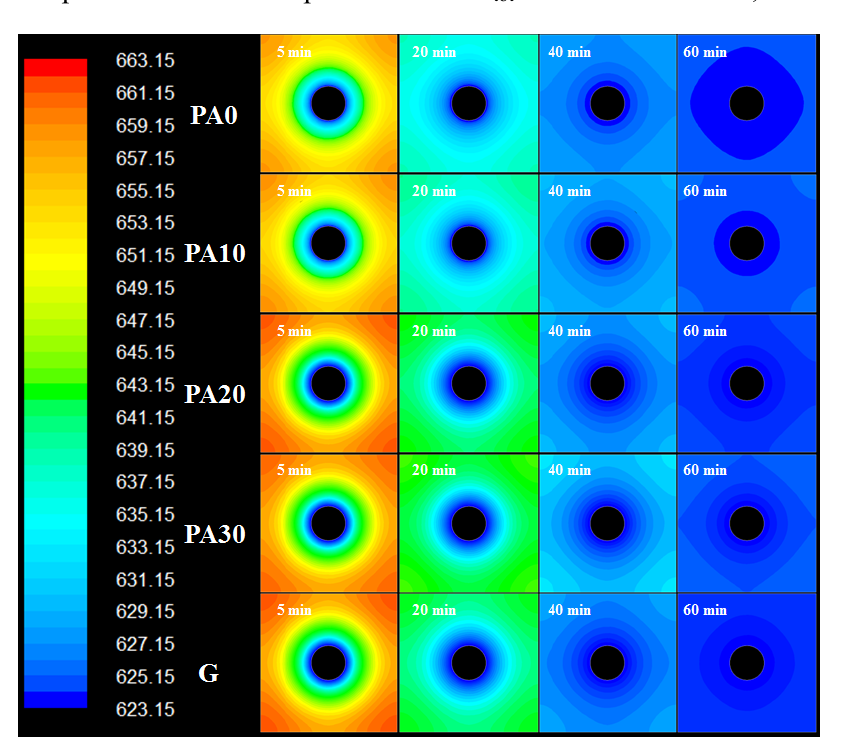
Figure 17. Temperature contour maps at constant V